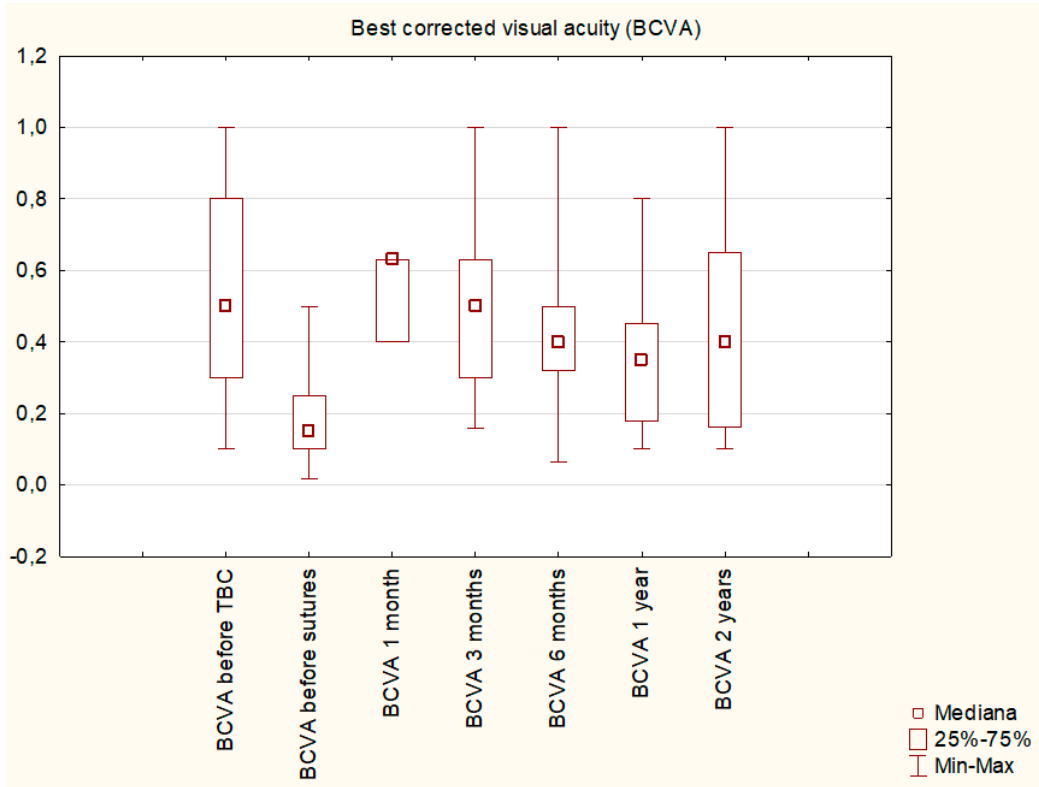
Figure 1. Changes in the intraocular pressure during the study period. Success criterion 1 (IOP over 6 mmHg) at 7 days post-procedure was achieved in 15 (88%) patients, after 3 months in 10 (59%) patients, and after 6 months in 9 (53%) patients (and remained stable during the first and second year of follow-up). Mean BCVA before applying the sutures was 0.18 ± 0.13 and increased to 0.53 ± 0.25 ( p = 0.0004) after 1 month; to 0.46 ± 0.31 ( p = 0.005) after 6 months; and to 0.31 ± 0.22 ( p = 0.025) after one year (Figure 2).